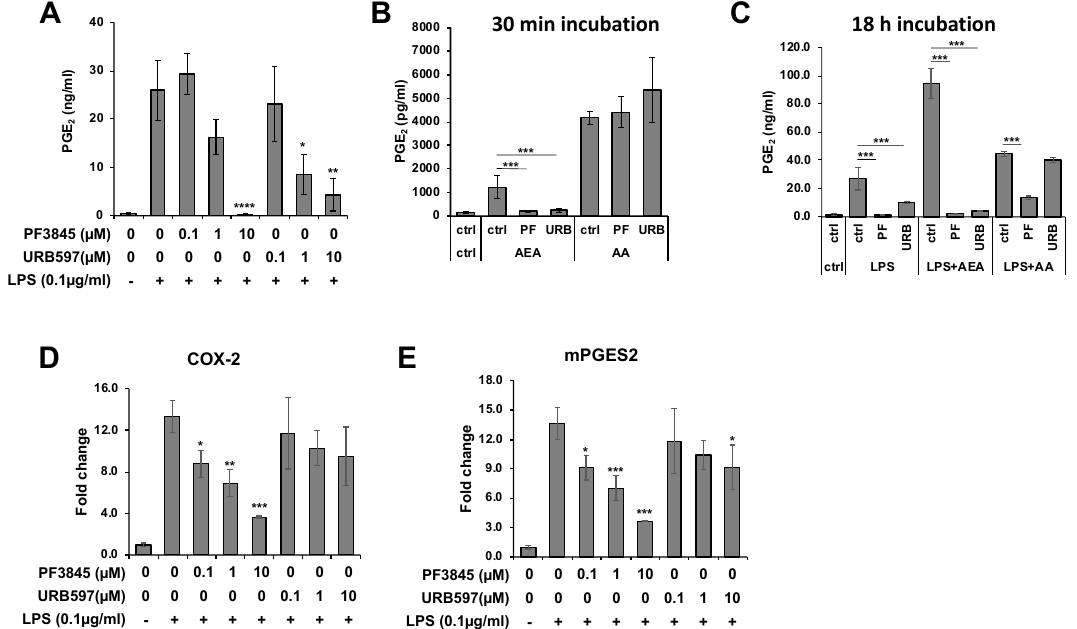
Figure 2. PGE 2 production and the biosynthetic enzyme expression a ff ected by FAAH inhibitors. BV2 cells were treated with LPS and FAAH inhibitor at the indicated concentration for 18 h, and PGE 2 in the medium was measured by EIA ( A ). Activated BV2 cells pretreated with LPS for 18 h were incubated in the medium containing AEA (10 µ M) or AA (10 µ M) and PF3845 (10 µ M) or URB597 (10 µ M) for 30 min. PGE 2 in the medium was assayed with EIA ( B ). BV2 cells were incubated with LPS and PF3845 (10 µ M) or URB597 (10 µ M) in the presence of AEA (10 µ M) or AA (10 µ M) for 18 h. PGE 2 in the medium was assayed using EIA ( C ). Expression levels of COX-2 ( D ) and mPGES2 ( E ) were determined relative to GAPDH in BV2 cells after 8 h treatment with LPS and inhibitor at indicated concentrations. The + and – symbols indicate the presence or absence, respectively, of LPS. Data are presented as means ± S.D. (n = 3). *, **, and *** denote p < 0.05, p < 0.01, and p < 0.001,